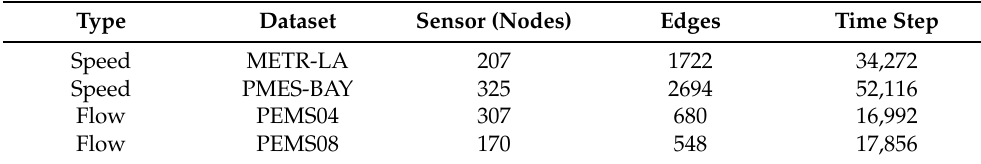
Table 1. The details of the